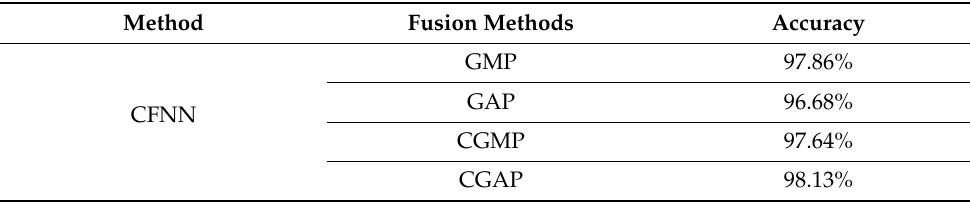
Table 4. Accuracy of the CFNN with various fusion